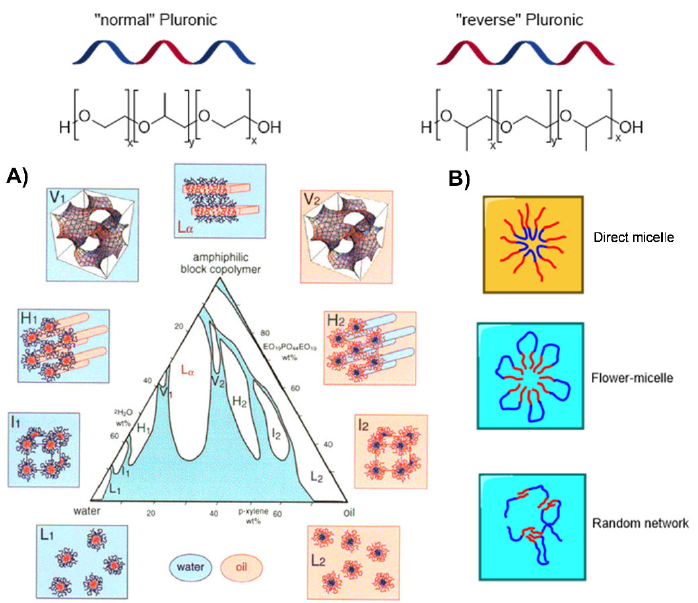
Figure 1. Overview of the different supramolecular structures formed by Pluronic polymers. ( A ) Example of normal P84 in water and p -xylene (l 1 , H 1 , V 1 , L α , V 2 , H 2 and l 2 ) indicate normal (direct, “oil-in-water”) micellar cubic, normal hexagonal, normal bicontinuous cubic, lamellar, (reverse,